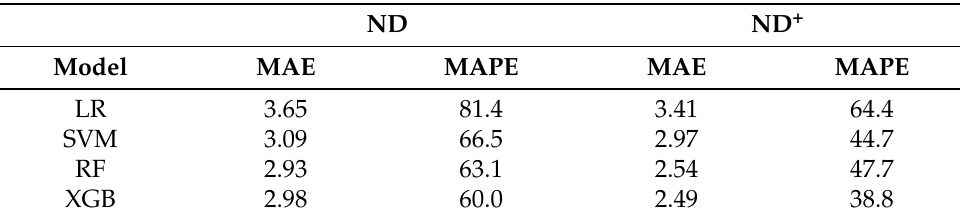
Table 5. Performance of each model for each dataset.